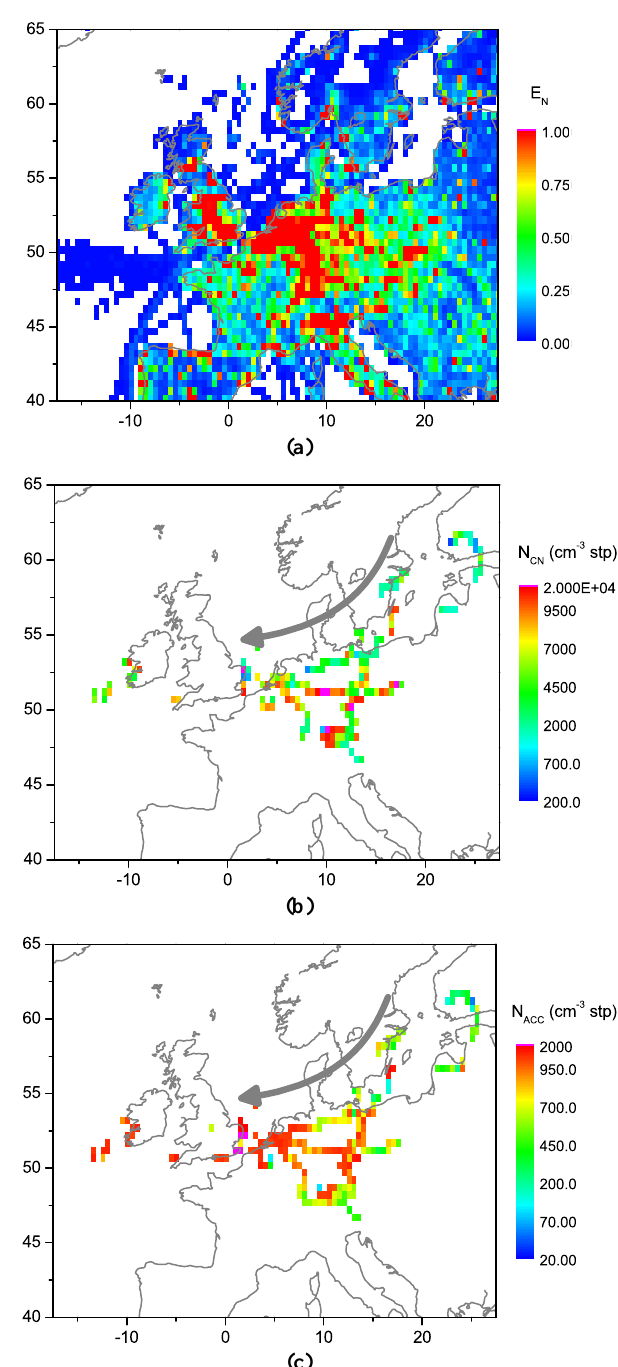
Fig. 2. Normalized emission factor E N (a) based on the EDGARv4.1 emission database (http://edgar.jrc.ec.europa.eu/) and horizontal distributions of CN (b) and ACC (c) number concen- trations within the boundary layer derived from DLR Falcon 20 and FAAM BAe-146 measurements. Average values are given for a 0.5 ◦ × 0.5 ◦ grid. The grey arrow (b, c) indicates the main air mass transport direction. Please note the logarithmic colour scale for the particle number